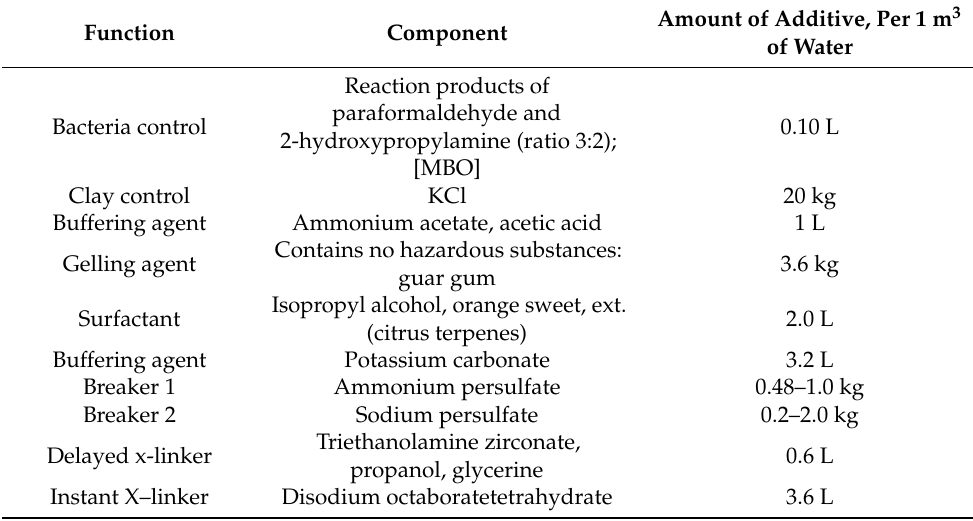
Table 2. Composition of the fracturing fluid used at the third stage of well